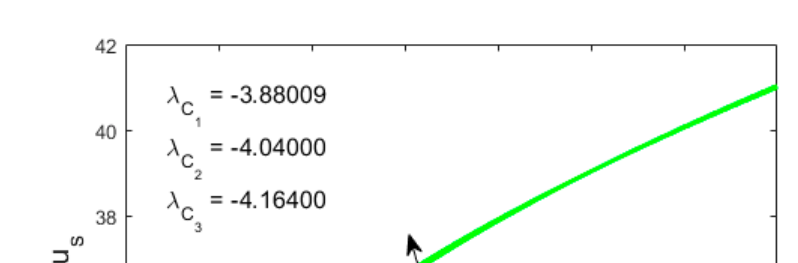
0.5 Re C versus λ . s F